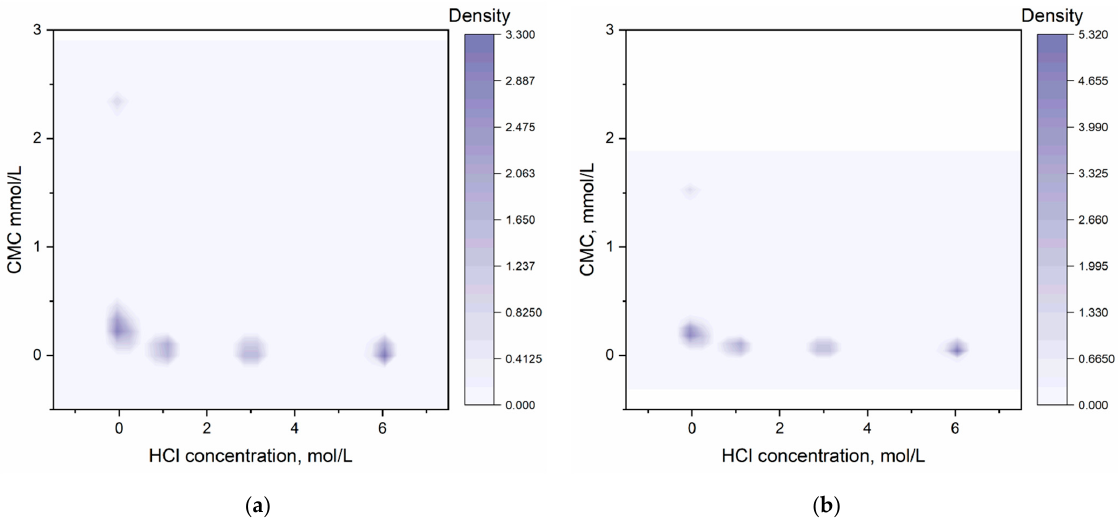
Figure 4. 2D Kernel density graph for ( a ) ABS and ( b ) ABSNa50 surfactants. The results indicate that the CMC reduction is related to the additional ions in the system that come from the dissociation of acid and their interactions with the surfactants, but the explanation of this phenomenon is not so obvious. It should be noted that as the concentration of HCl increases, a lower scatter of the obtained CMC results for different metal salts is observed. This indicates that the presence of acid determines to a much larger extent the surface